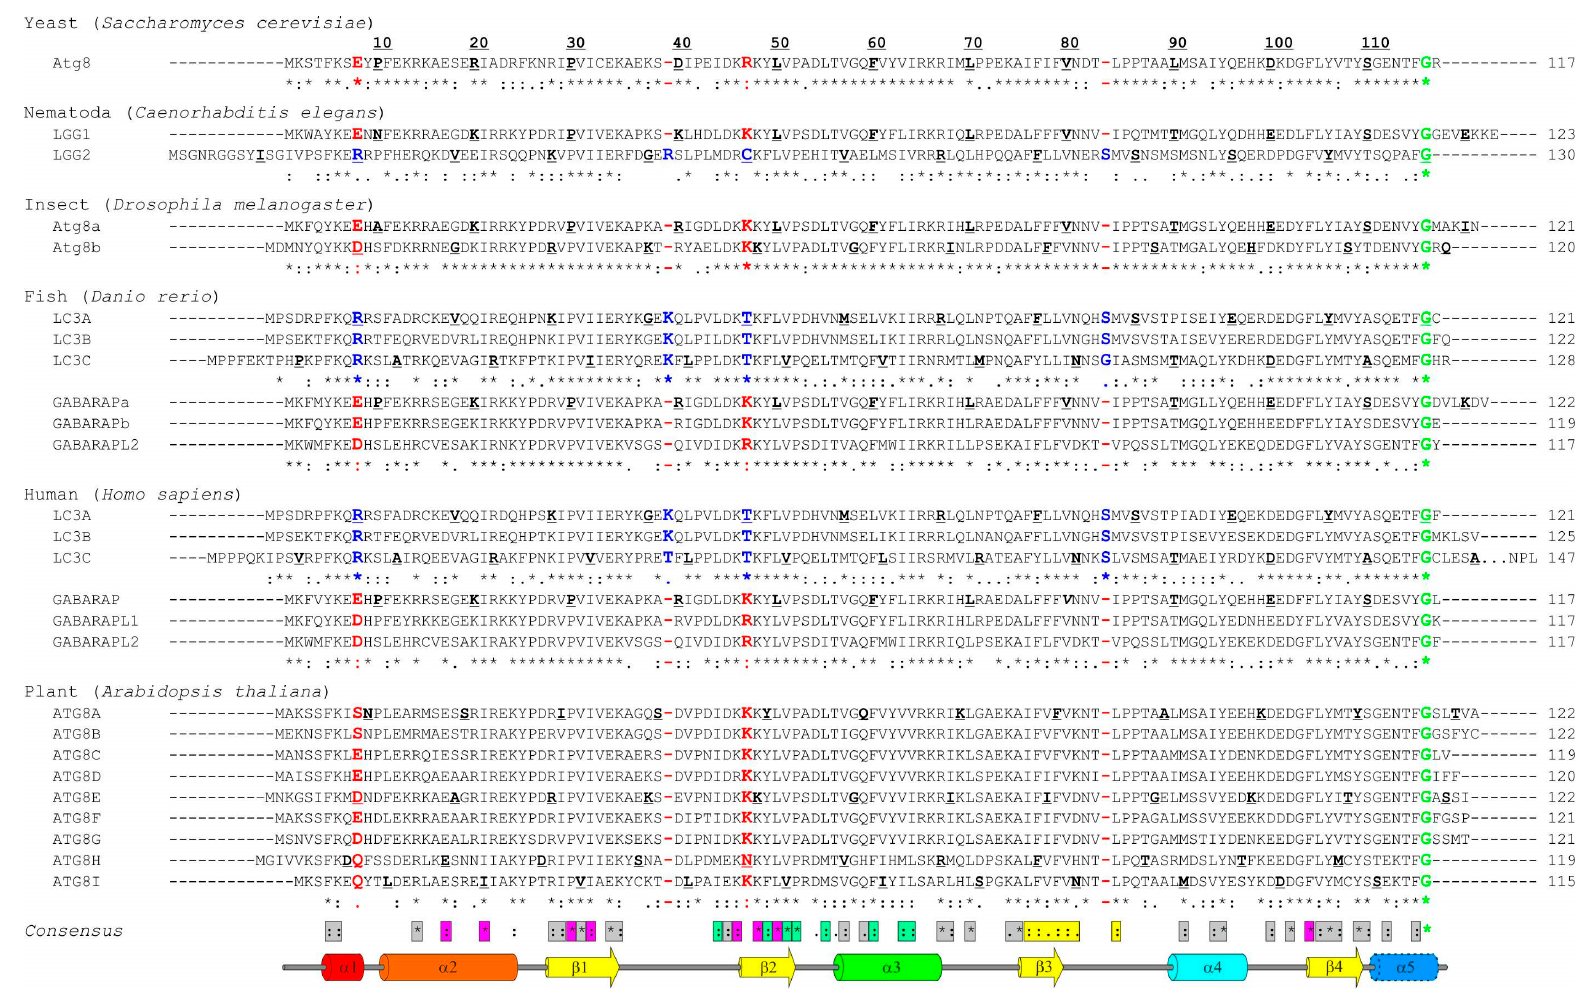
Figure 2. Sequence alignment of Atg8 / LC3 / GABARAP proteins. Sequence alignment of the Atg8-family members from six model species—yeast ( Saccharomyces cerevisiae) , Nematoda ( Caenorhabditis elegans ), insect ( Drosophila melanogaster ), fish ( Danio rerio ), human ( Homo sapiens ), and plant ( Arabidopsis thaliana ). Secondary